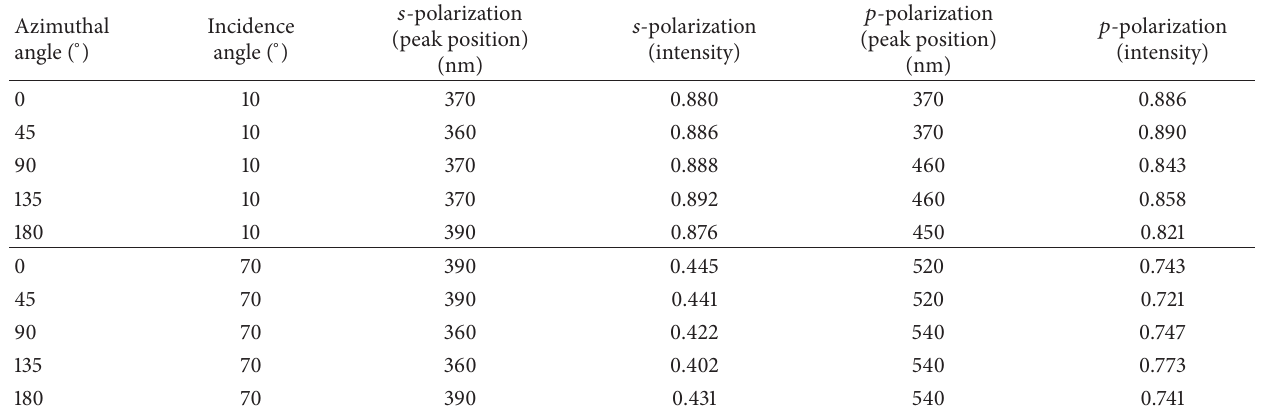
Table 2: Details of the absorbance ( 1−𝑅 ) peak wavelength and intensity for both 𝑠 - and 𝑝 -polarization extinction spectra of helical pentagon sculptured thin